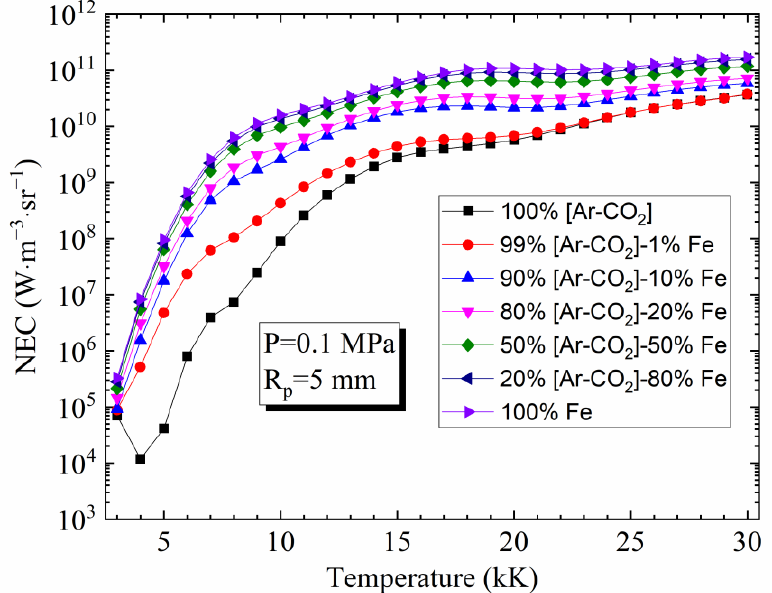
Figure 4. Influence of iron vapor on the NEC for [82%Ar-18%CO2]- Fe mixtures (molar proportions) at atmospheric pressure and R p = 5 mm.